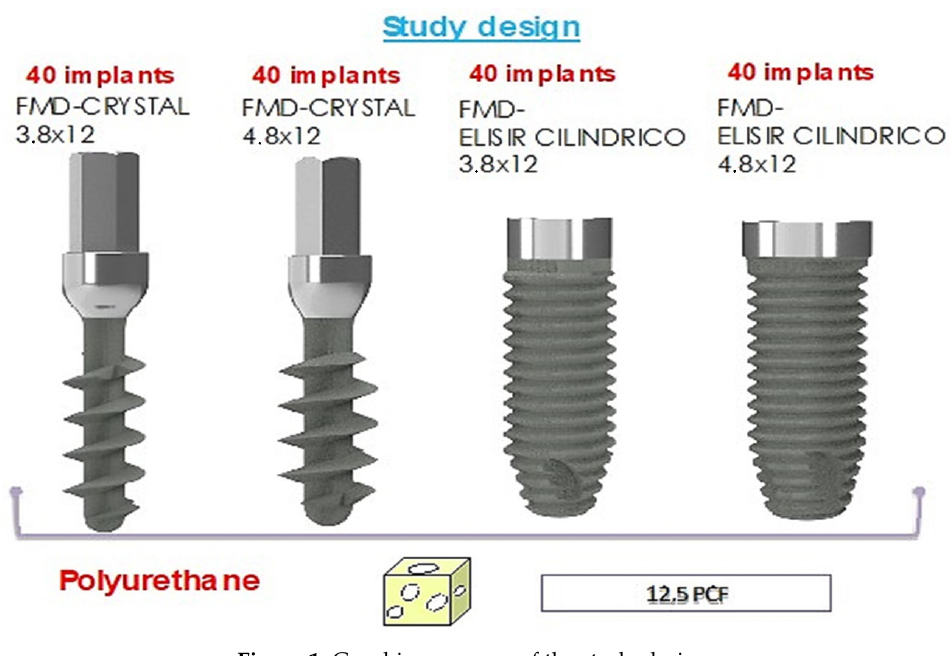
Figure 1. Graphic summary of the study design.